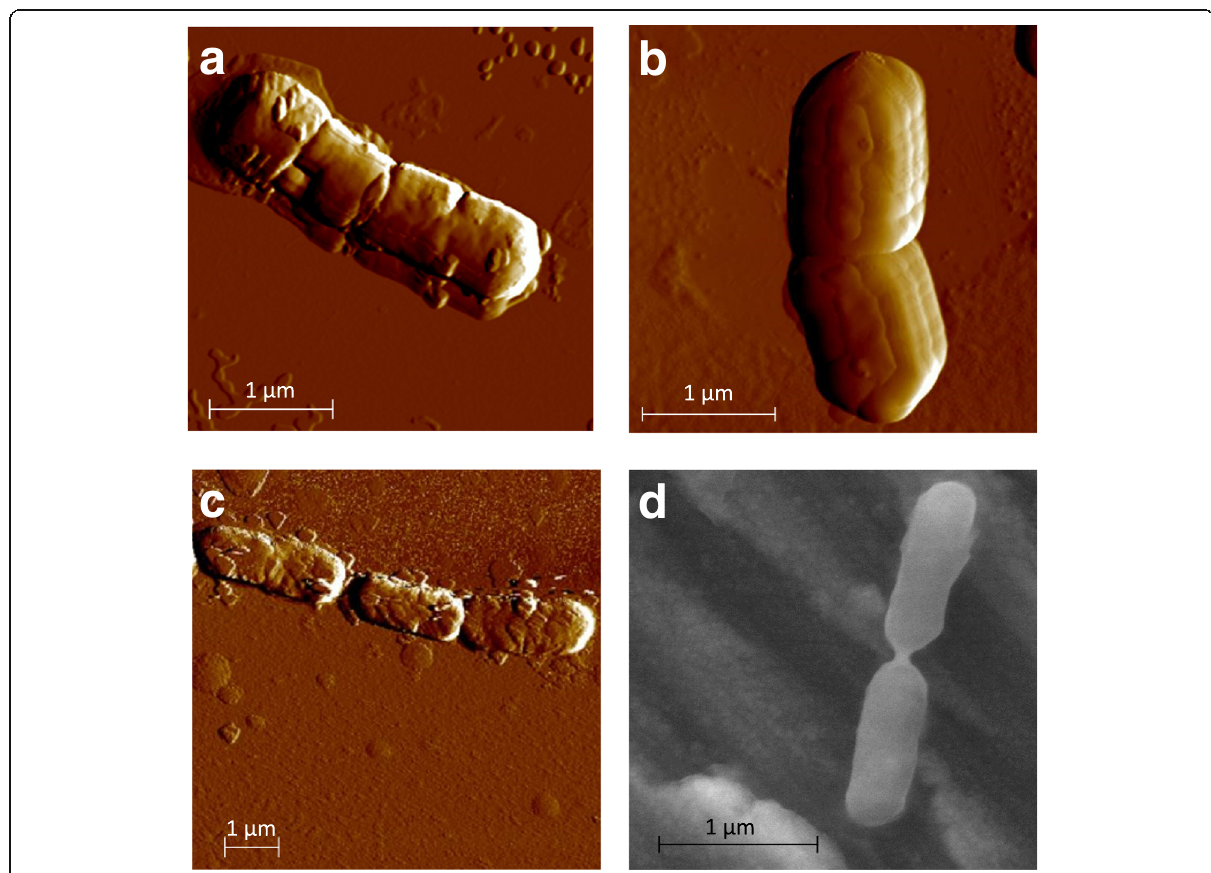
Fig. 2 Microscopy pictures of liquid-grown Brochothrix thermosphacta cultures. Brochothrix thermosphacta CD 337 ( a ), B. thermosphacta EBP 3070 ( b ), B. thermosphacta BSAS1 3 ( c ) were imaged by atomic force microscopy, and B. thermosphacta TAP 175 ( d ) was generated by scanning electron microscopy. The scale bars represent 1 μ